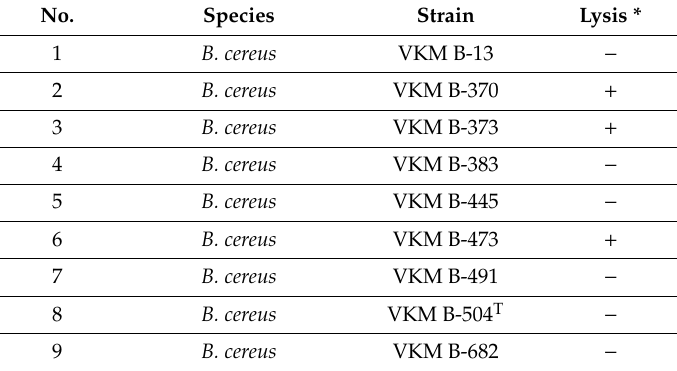
Table 1. The host range of Bacillus phage B83 on 30 Bacillus